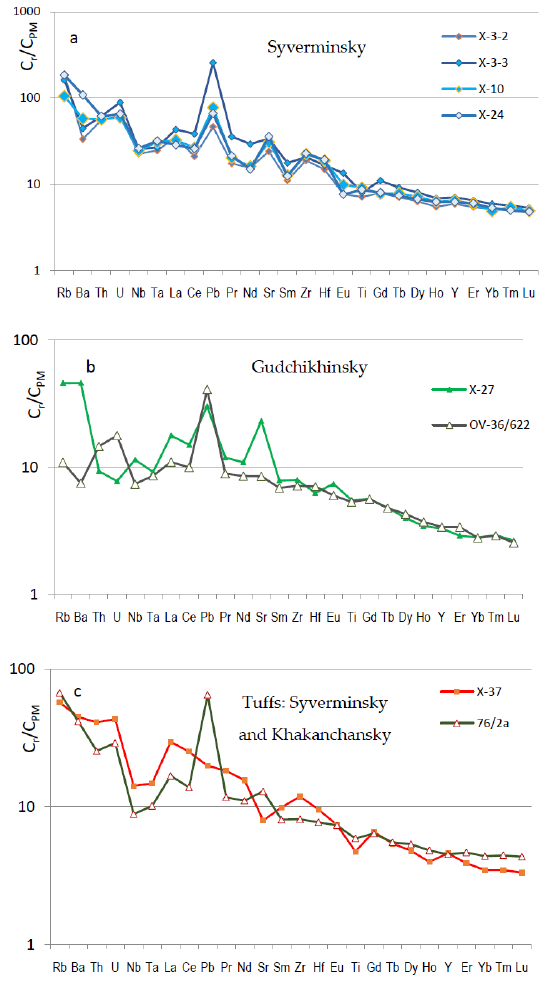
Figure 11. Spider-diagrams for basalts of the Syverminsky formation ( a ), Gudchikhinsky formation ( b ) and tuffs ( c , the Khalil site, Norilsk area). Samples OV-36/622 and 76/2a—from the Norilsk area. Here and in Figures 15 and 16 elements are normalized to primitive mantle after [60].